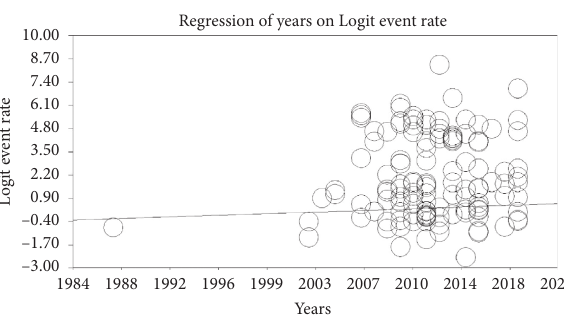
Figure 6: Metaregression of the relationship between the study year and the prevalence of aflatoxin M1 in milk.